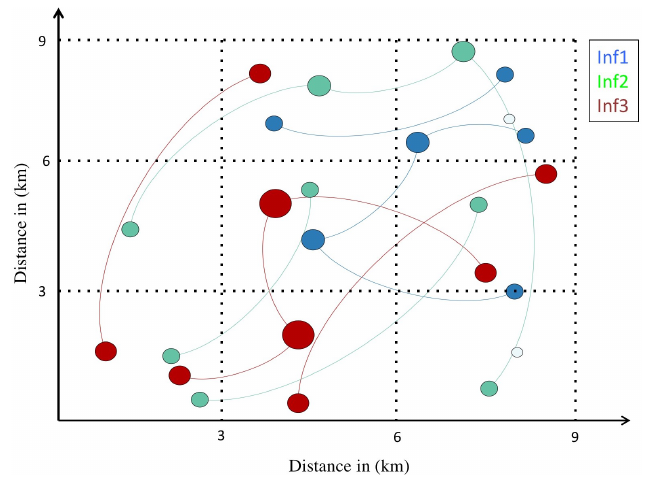
Figure 3. Critical node geographic